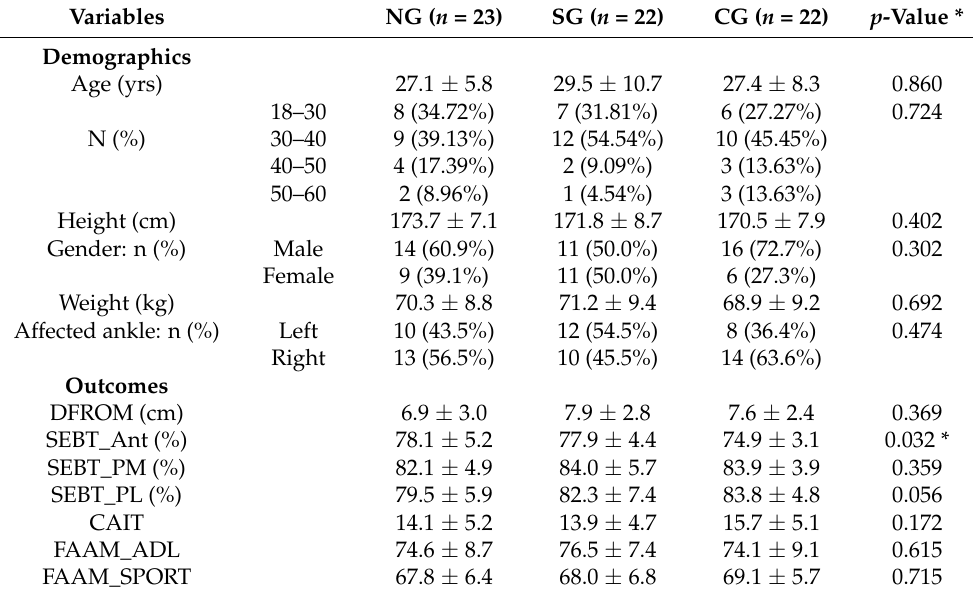
Figure 3. Flow chart of the study design and participants’ follow-up through the trial. Table 1. Descriptive summary of baseline